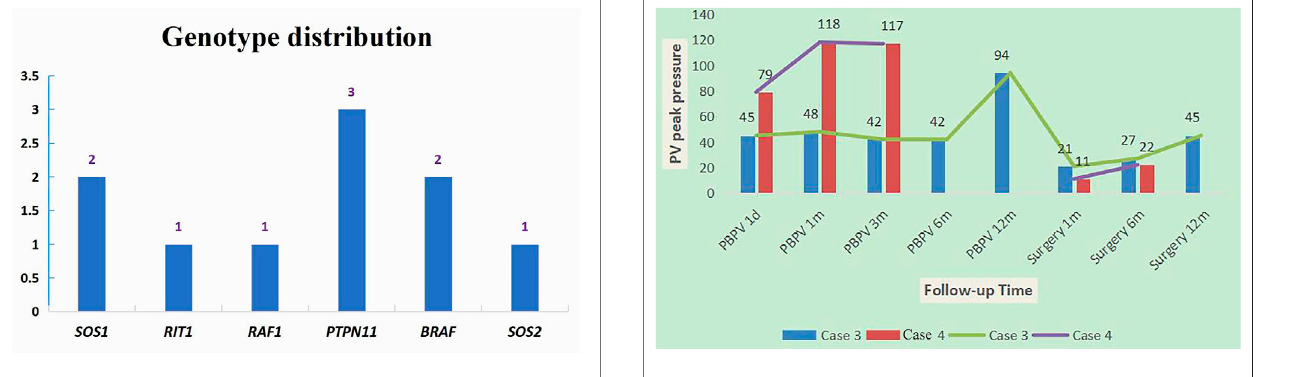
FIGURE 4 | Genotype distribution in interventions patients. FIGURE 5 | Follow-up results in case 3 and case